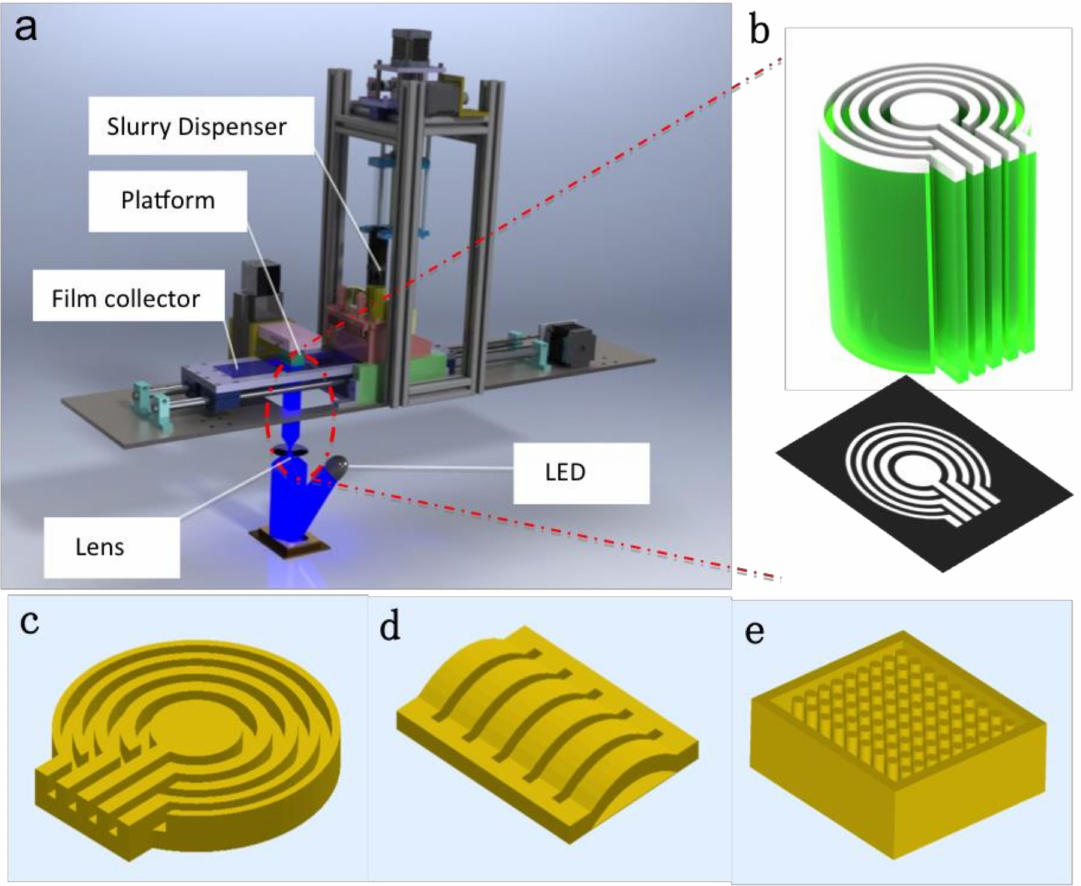
Figure 1. ( a ) sketch of Mask-Image-Projection-based Stereolithography system. ( b ) Green part controlled by image pattern. ( c – e ) 3D model designed by SolidWork.